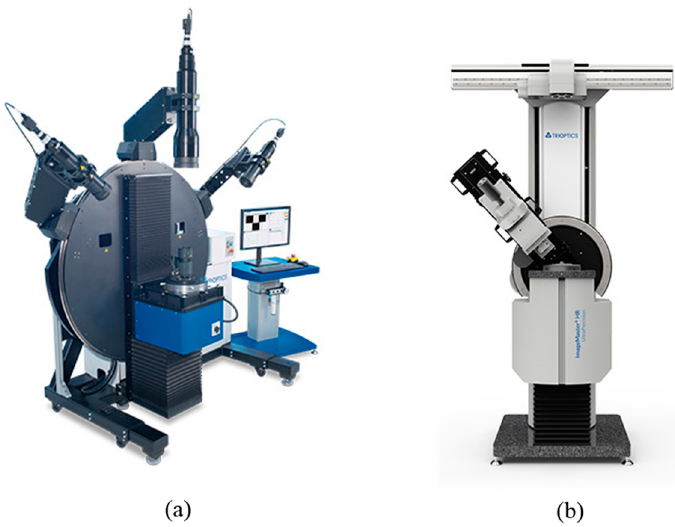
Figure 3. Tripotics Products: ( a ) Image master cineflex ( b ) Image master HR / universal.